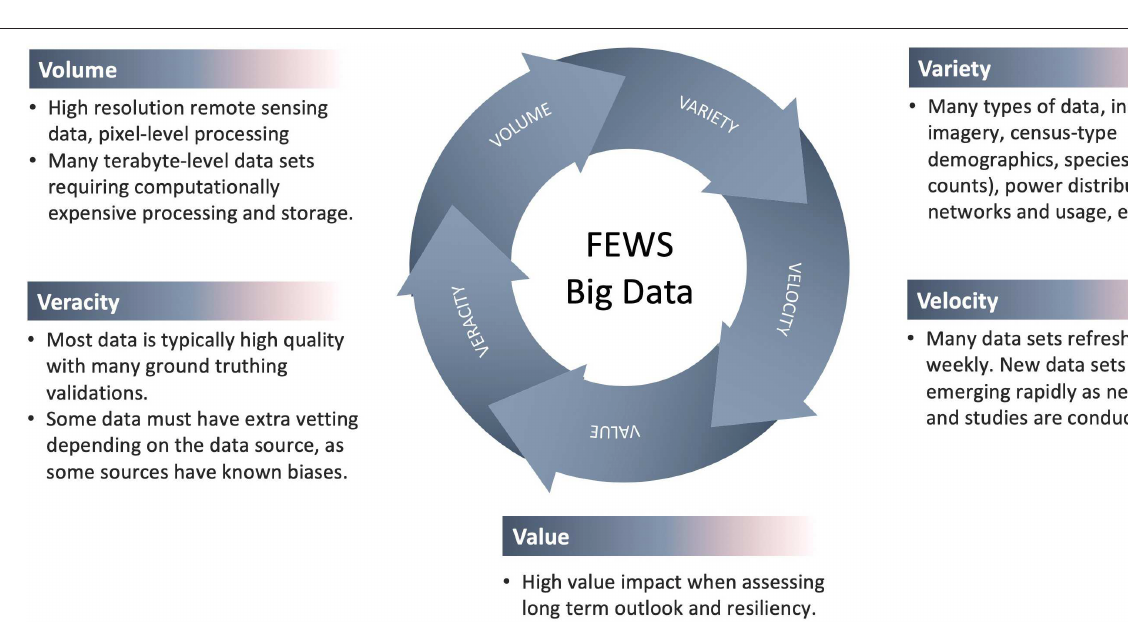
Frontiers in Big Data |